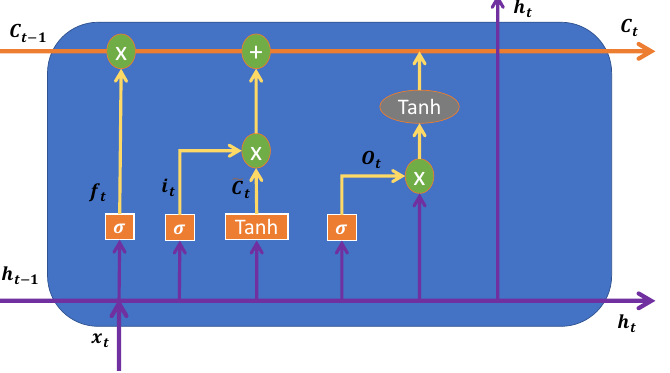
Figure 5. Architecture of an LSTM cell; adapted from [73–75].